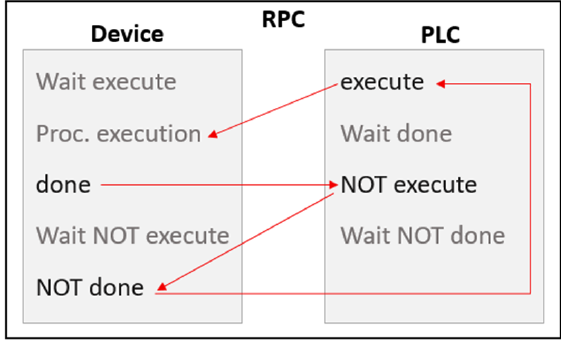
Figure 5. Connection of the PLC_Beckhoff SC to the SCs representing the controllers of the devices in the assembly cell.